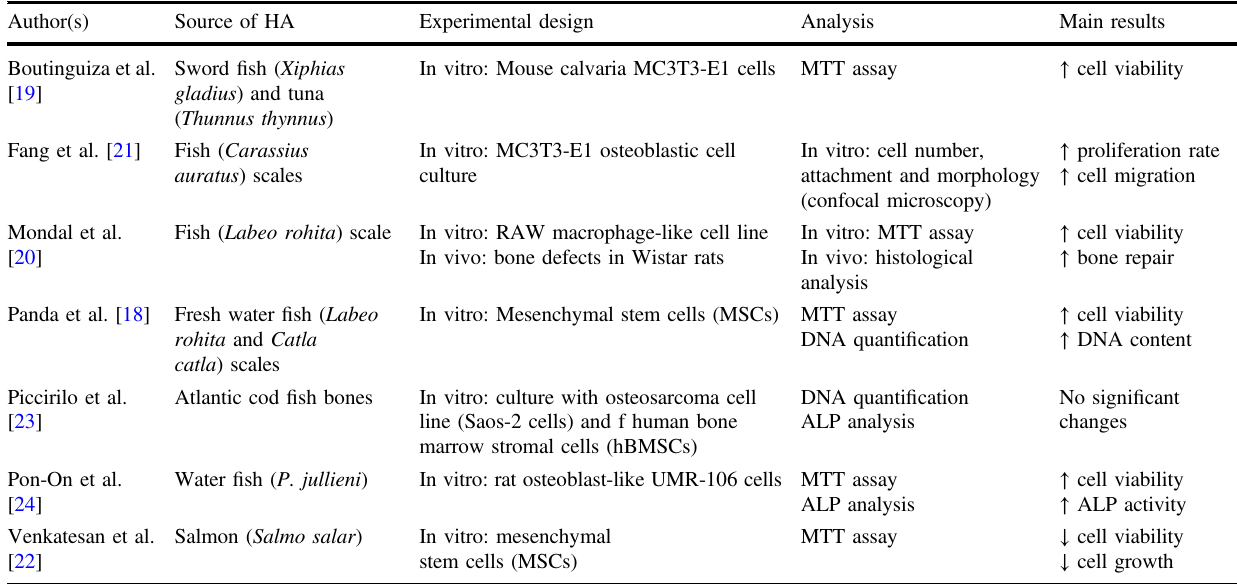
Table 1 In vitro and in vivo studies of hydroxyapatite (HA) from fi sh in alphabetical